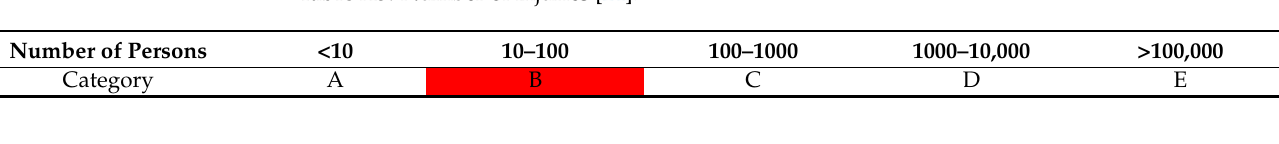
Table A3. Number of injuries [24].